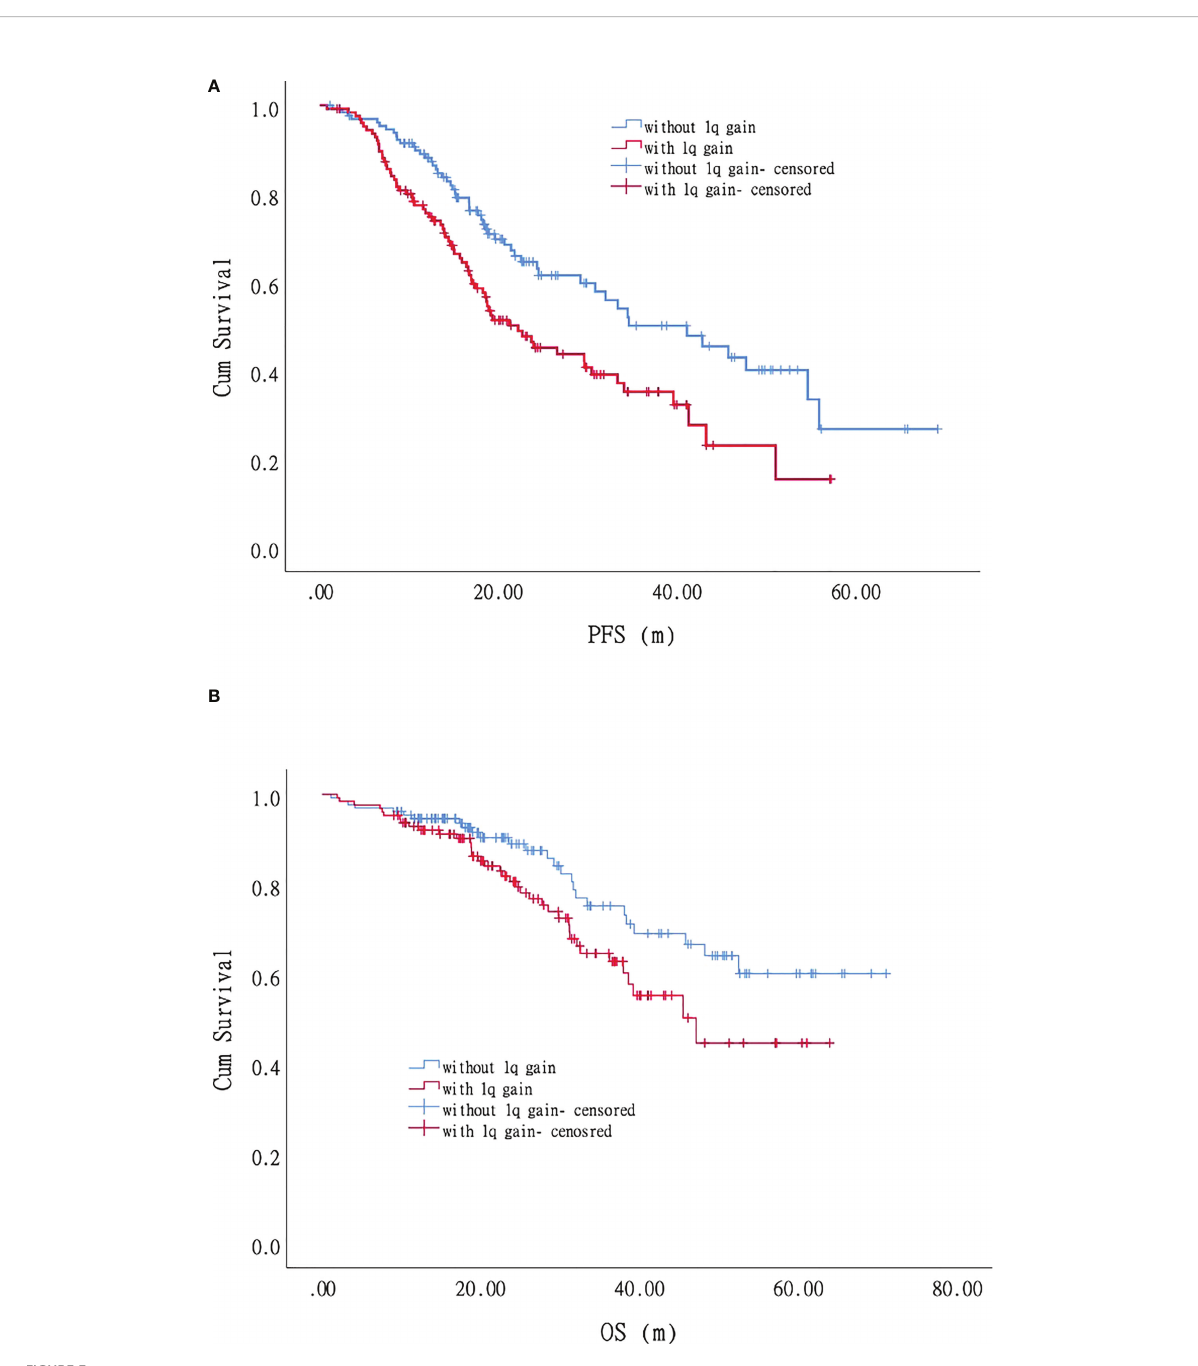
FIGURE 3 Impact of +1q on progression-free survival (PFS) and overall survival (OS) of patients with myeloma: Patients with +1q had shorter PFS and OS. (A) . Progression-free survival. (B) . Overall